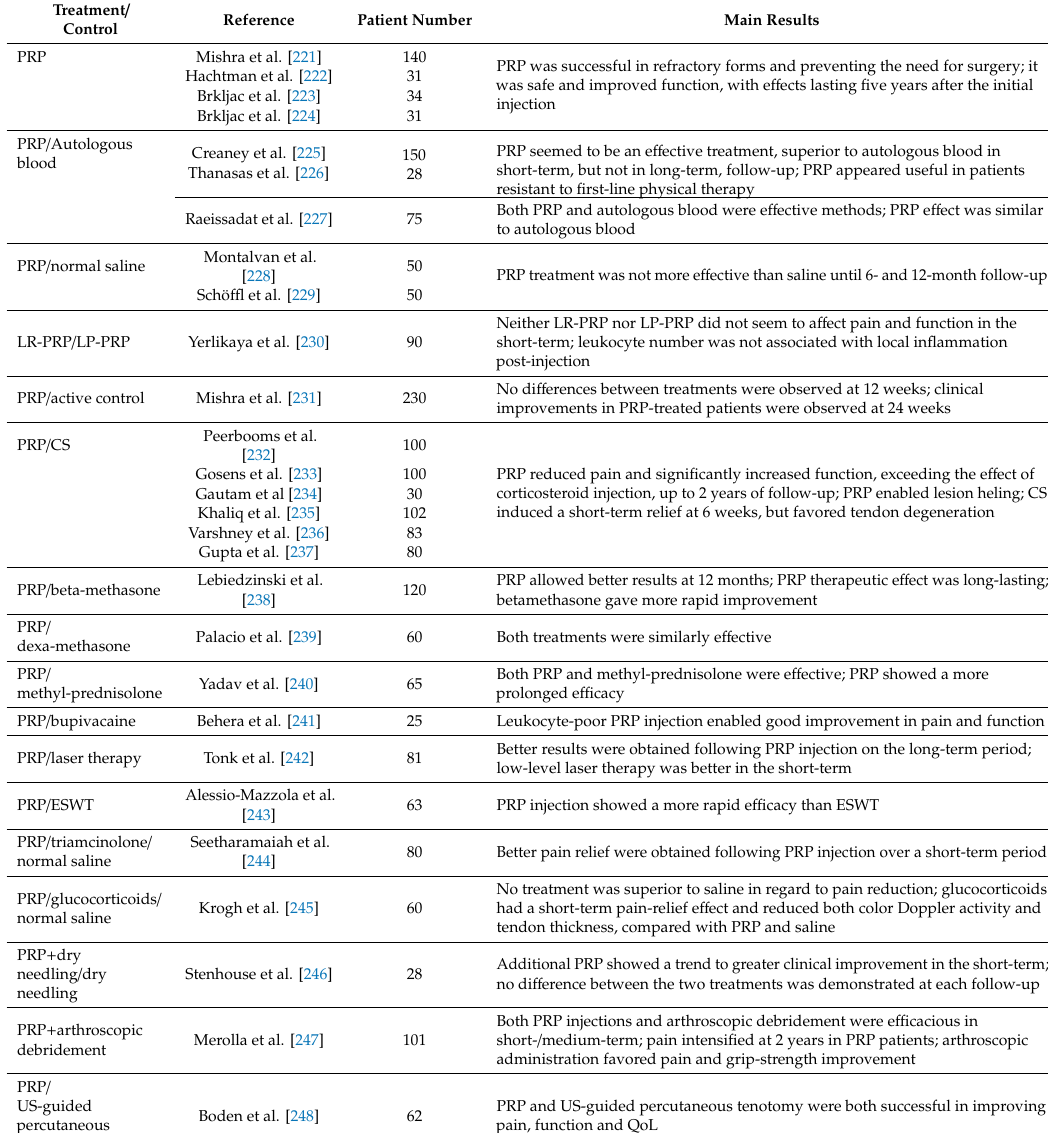
Table 6. Evidence of PRP treatment in lateral epicondyle tendinopathy (reported by year of study and grouped by